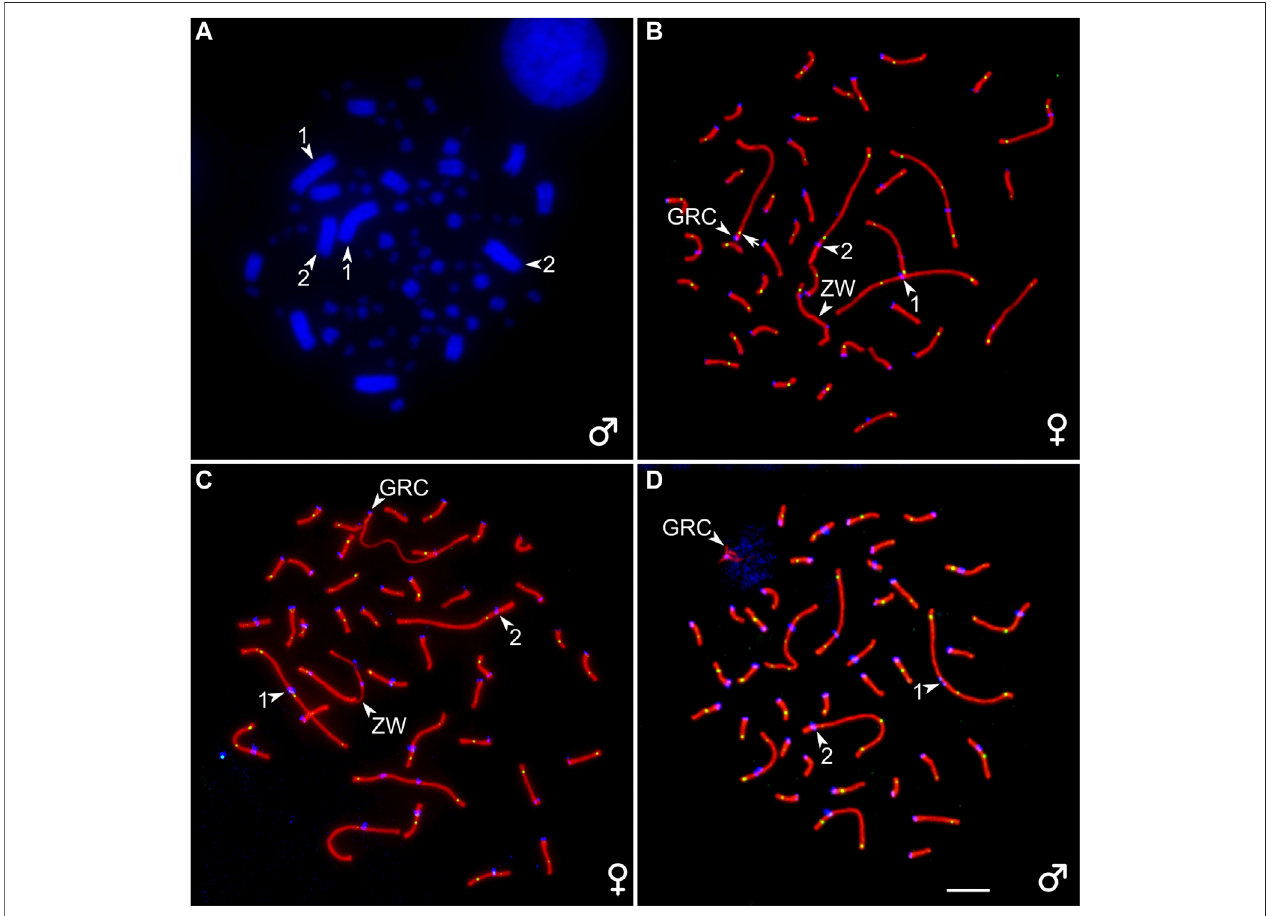
FIGURE 1 | (A) DAPI-stainedbonemarrowcellofthemalegreattit. (B – D) Pachyteneoocytes (B, C) andspermatocyte (D) ofthegreattitwithtwo (B) and one (C, D) copiesofGRCafter immunostainingwithantibodiestoSYCP3(red),centromereproteins (blue), and MLH1(green).The arrowheadspoint tocentromeresofthe two largest macrobivalentsandZWbivalent(identi fi edbyheteromorphicSCandunalignedcentromeres)andGRC.ThearrowpointstotheMLH1signalatGRCbivalent (B) .Bar – 5 μ m.